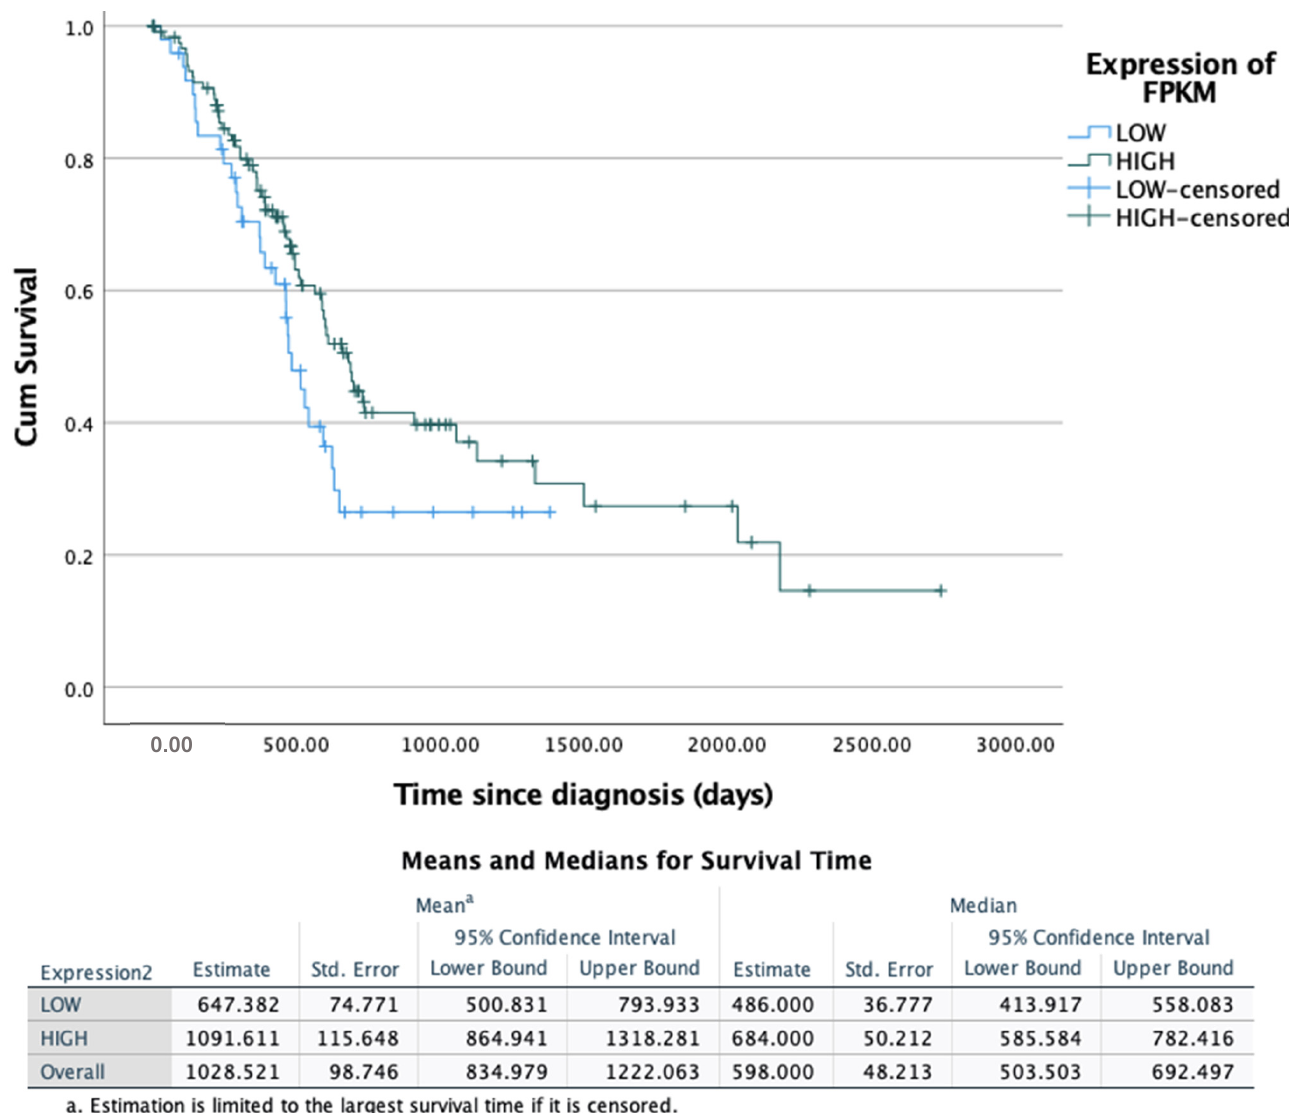
Figure 5. Kaplan-Meier plot showing the survival analysis of CDK4 expression (quantified by expression of FPKM reported) for pancreatic ductal adenocarcinoma patients ( n = 173). Expression groups determined by: low < 15.07, high > 15.07. No statistical significance was observed ( χ 2 (1) = 3.312, p = 0.069, >0.05).